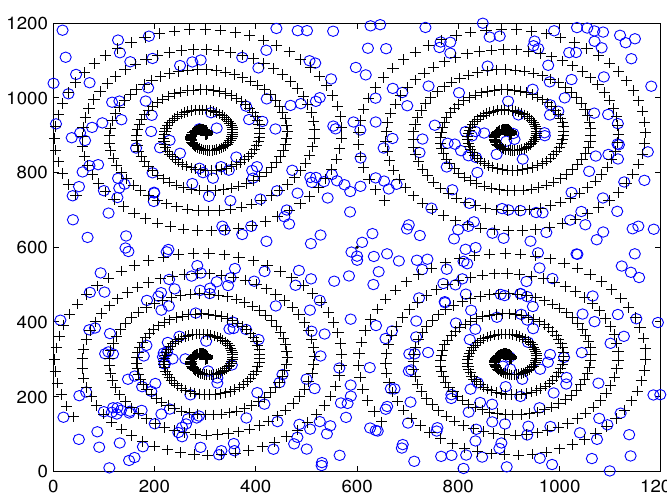
Figure 3. Network design of spiral mobility executed with multiple sinks for large-scale